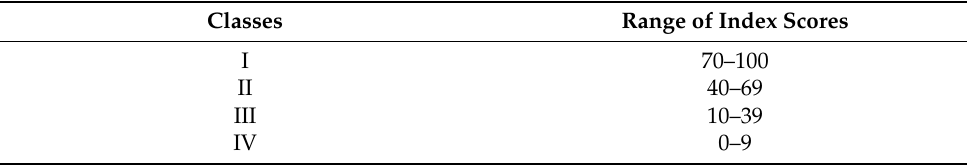
Table 12. The distinct classes according to the range of index scores.